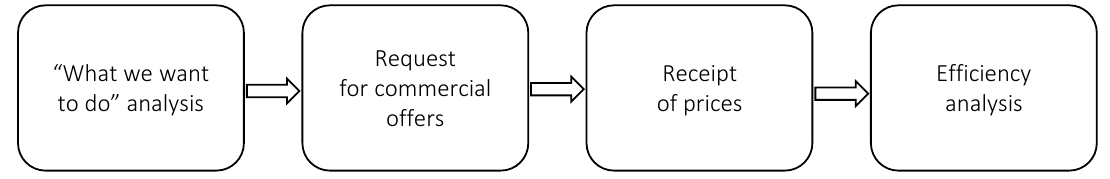
Figure 1. Diagram of the resource management process for the project in